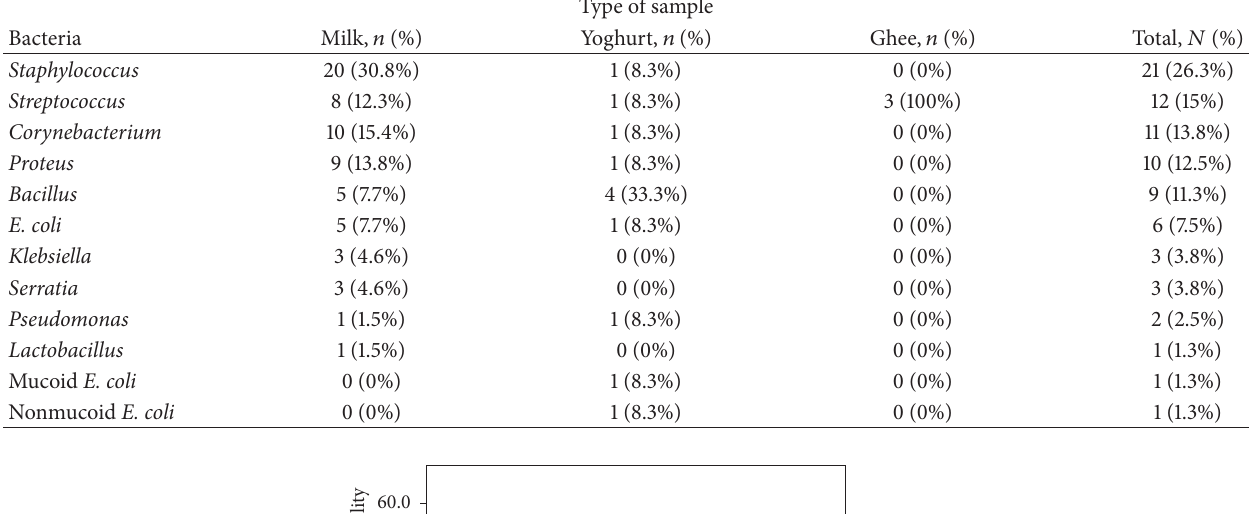
Table 1: Sources of the different bacterial isolates. Type of